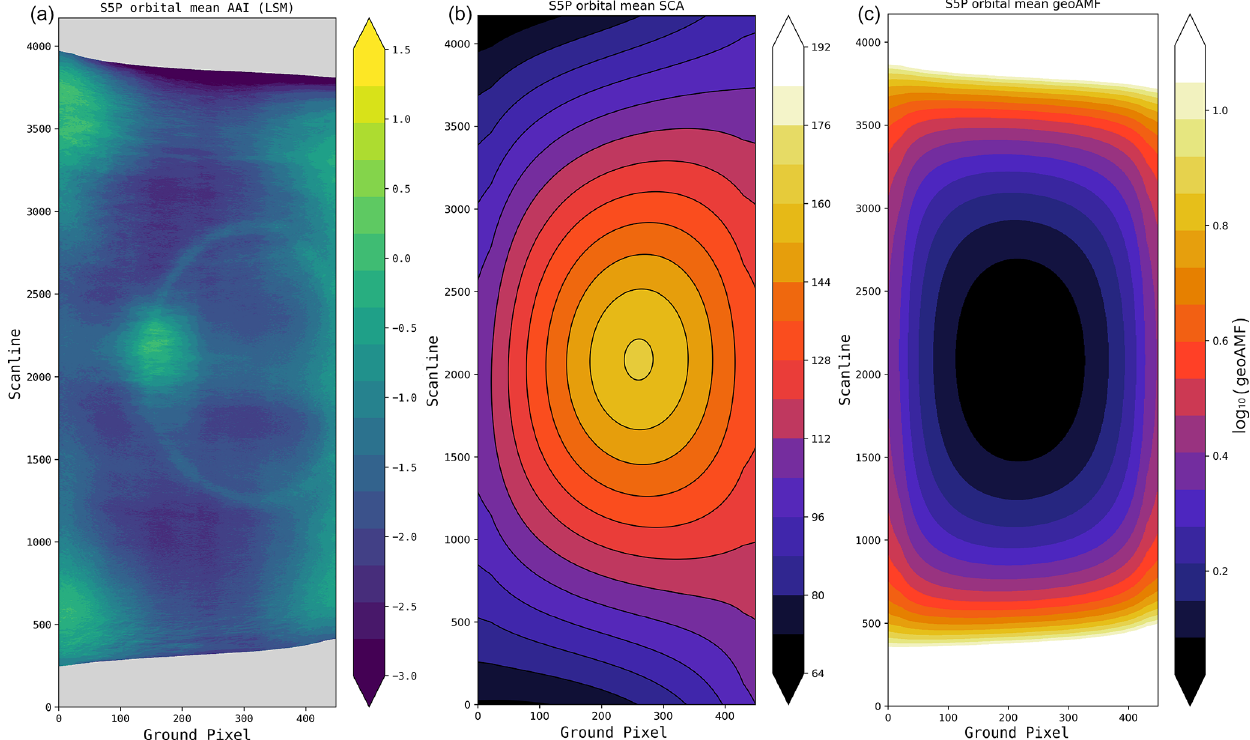
Figure 4. (a) Orbital distribution of TROPOMI AAI averaged over 54 orbits over the Pacific. For guidance, panel (b) displays the corre- sponding single scattering angles, defined as (cid:50) in Eq. (1), and (c) the log 10 of the geometric air mass factor, defined as µ − 1 biases in the AAI are present at the cloud bow, which is at the expected single scattering angle of around 138 ◦ , and at more extreme viewing and solar geometries (large geometric air mass